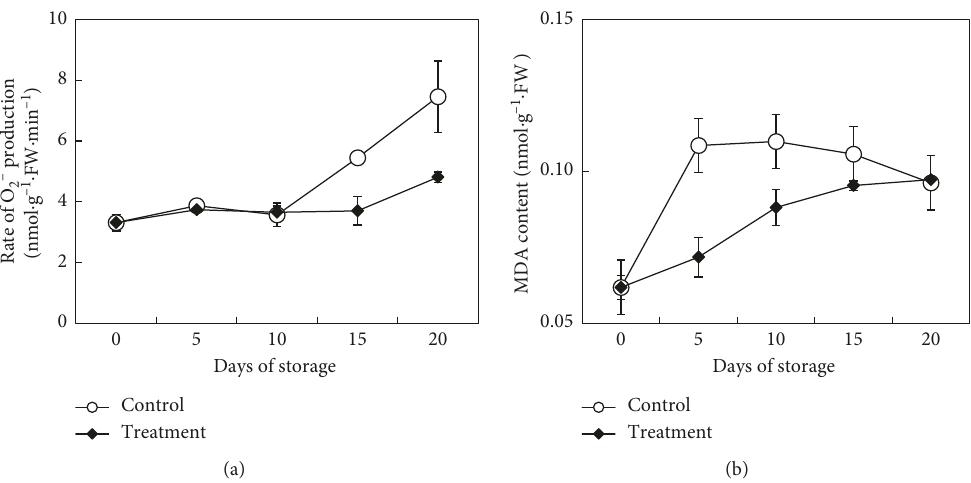
Figure 7: Effects of forced air precooling treatment on O